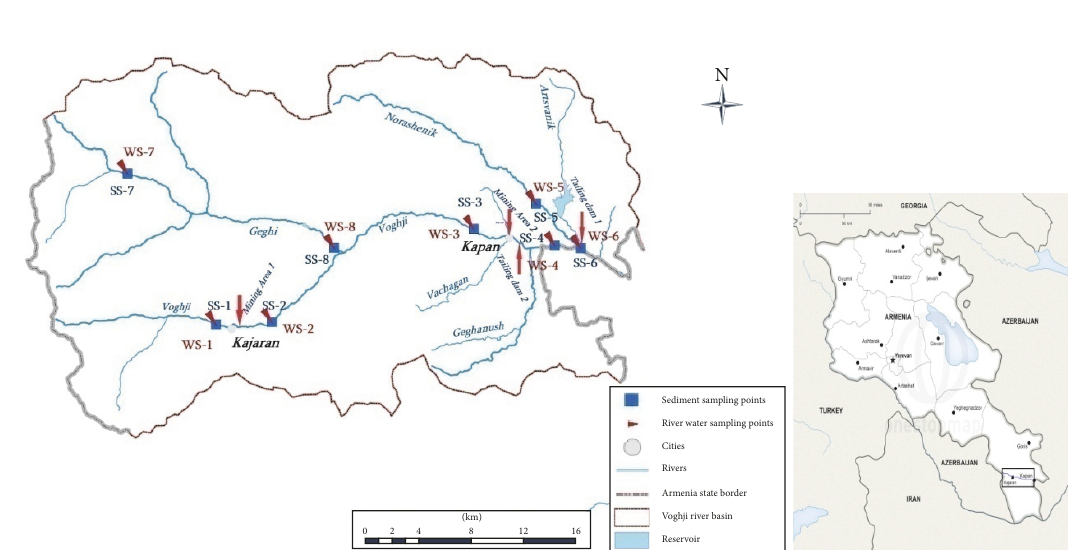
Figure 1: Map of the study area and location of sampling points: (mining area 1) ZCMC; (mining area 2) KPM; (WS) water sampling sites; (SS) sediment sampling sites; red arrows indicate pollution